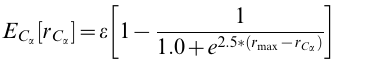
Figure S1 Root mean square displacement of the C a atoms of the equatorial chains compared to the initial condition. The time scale starts from 7 ns and goes all the way to 11 ns. The plateau demonstrates that the dynamics reached equilibrium. Figure S2 Schematic representation of the model used for the GROMACS full atomistic simulations. The part of the protein that was kept constrained in space is shown in grey. The chains that were free to fluctuate are shown in light blue. The water molecules that fully solvated the protein complex are not shown. The axes are drawn to indicate the coordinate system used in the calculation of the filament density profiles. Figure S3 Real-space representation of the backbone of the caterpillar model. The large blue sphere represents the self- avoidance area of the C a atoms in with a radius of 2.5 A˚ . The H and O atoms interact through a 10-12 Lennard-Jones potential tuned with a quadratic orientation term that selects for alignment of the C H O and N atoms involved in a bond. The backbone fluctuates only around the torsional angles W 1 and W 2 . Figure S4 Real space snapshot of one configuration of the chains in the equatorial region equilibrated with the Monte Carlo simulation of the caterpillar model. The top and side view shows a fully blocked pore as seen in X-ray crystallography or Cryo-EM reconstruction. Figure S5 Plot of translocation free energy F ( Q,Q s ) as a function of the number of Helix-chains contacts Q and of the number of translocated residues Q s . We plot F ( Q,Q s ) for an attractive ( 2 0.2 kT ) interaction between the alpha helix and the chains. In this scenario the alpha helix is pulled towards the middle of the hole, and it is subject to two choices, either to stay there surrounded by the chains (low values of Q S and high values of Q ) or directly translocate (low values of Q S ). The small barrier ( , 2 k B T ) separating these two states suggests that the translocation can occur in one step (all the way down) or in two steps (first trapped for a while in the hole and then escaping). Figure S6 Plot of translocation free energy F 9 ( Q s )= F ( Q s ) 2 0.5 Q S where Q s is the number of translocated residues, and F ( Q s ) is the translocation free energy with repulsive (0.2 kT ) helix-chains interactions. The correction added to the free energy comes from the fact that the protein feels a gradient towards a a folded and translocated state. We extrapolated the coefficient 2 0.5 k B T per amino acids translocated, from previous work on lattice proteins [6]. Found at: doi:10.1371/journal.pcbi.1000006.s006 (0.07 MB